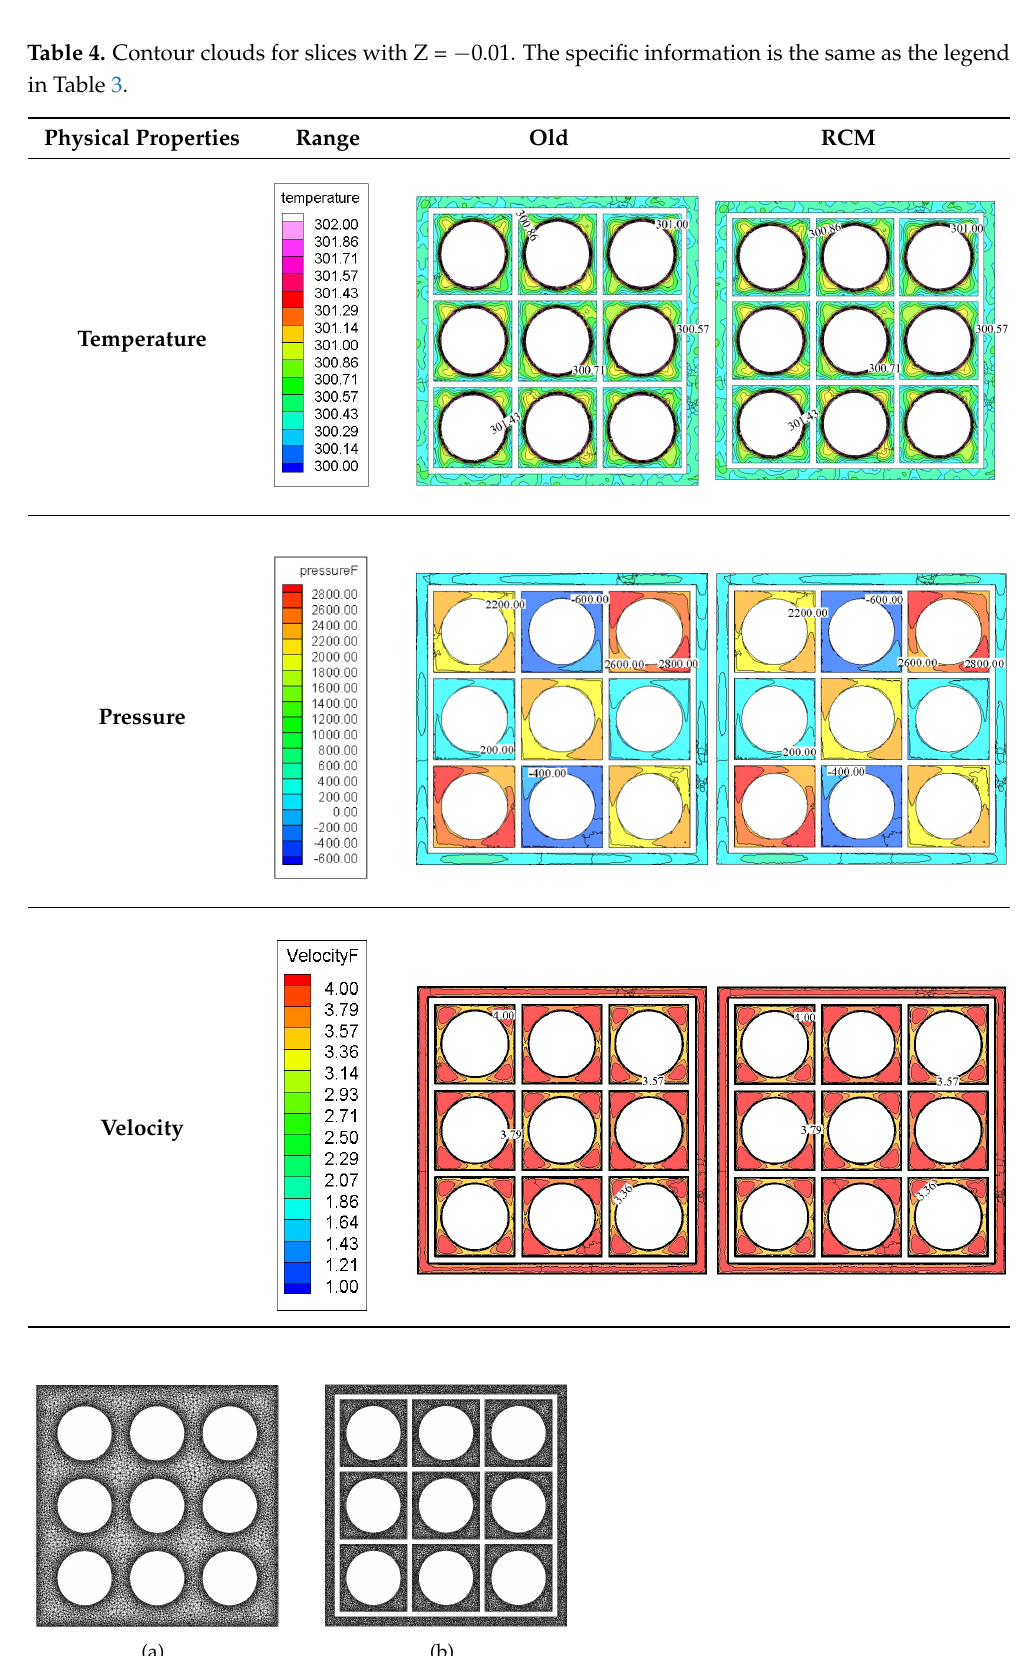
Figure 7. Slicing model. ( a ) slice with Z = 0.01; ( b ) slice with Z = − 0.01. In addition, slice ( b ) is located in the